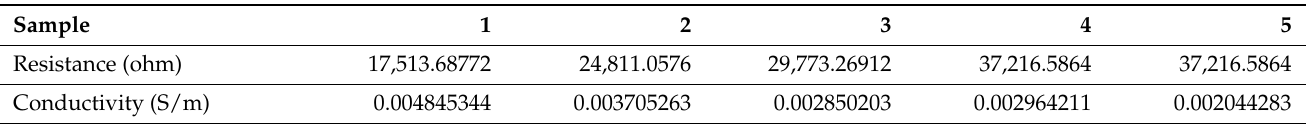
Table A13. Conductivity Data for Nylon 610 Nanocomposites with 2.5 wt% Graphite Nanosheets Treated at 150 ◦ C and − 1